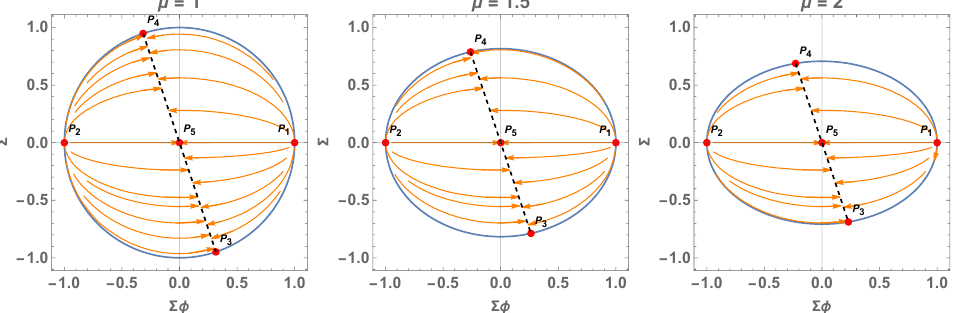
Figure 1. Phase plot for System (68)–(69) for (cid:101) = + 1 and different values of µ . The dashed black line corresponds to L 1